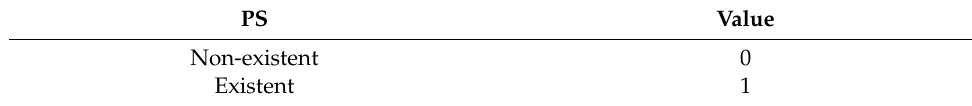
Table A3. Preventive silviculture and infrastructure factors’ assigned values.